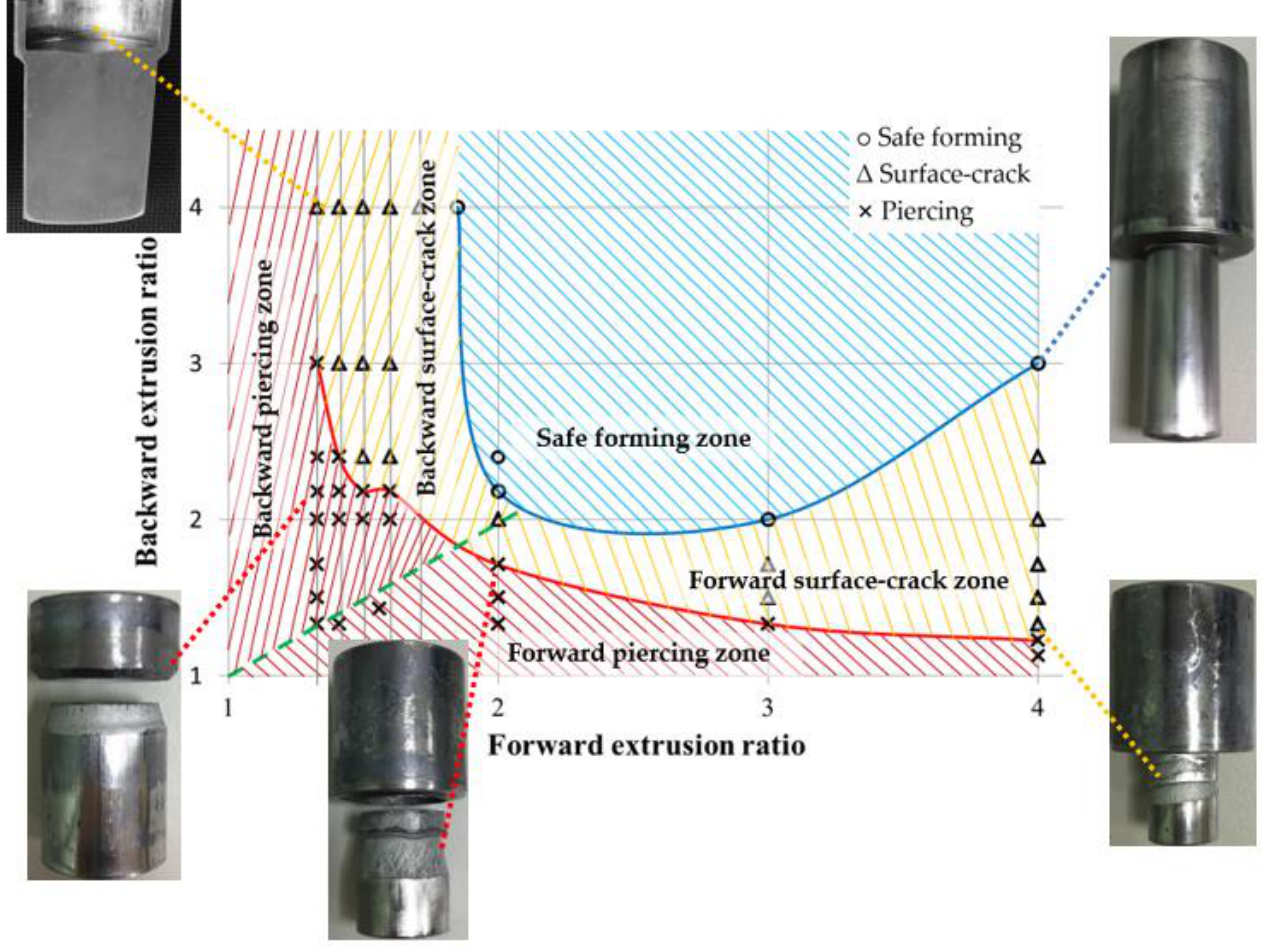
Figure 4. Forming limit diagram of CFBE experiment.